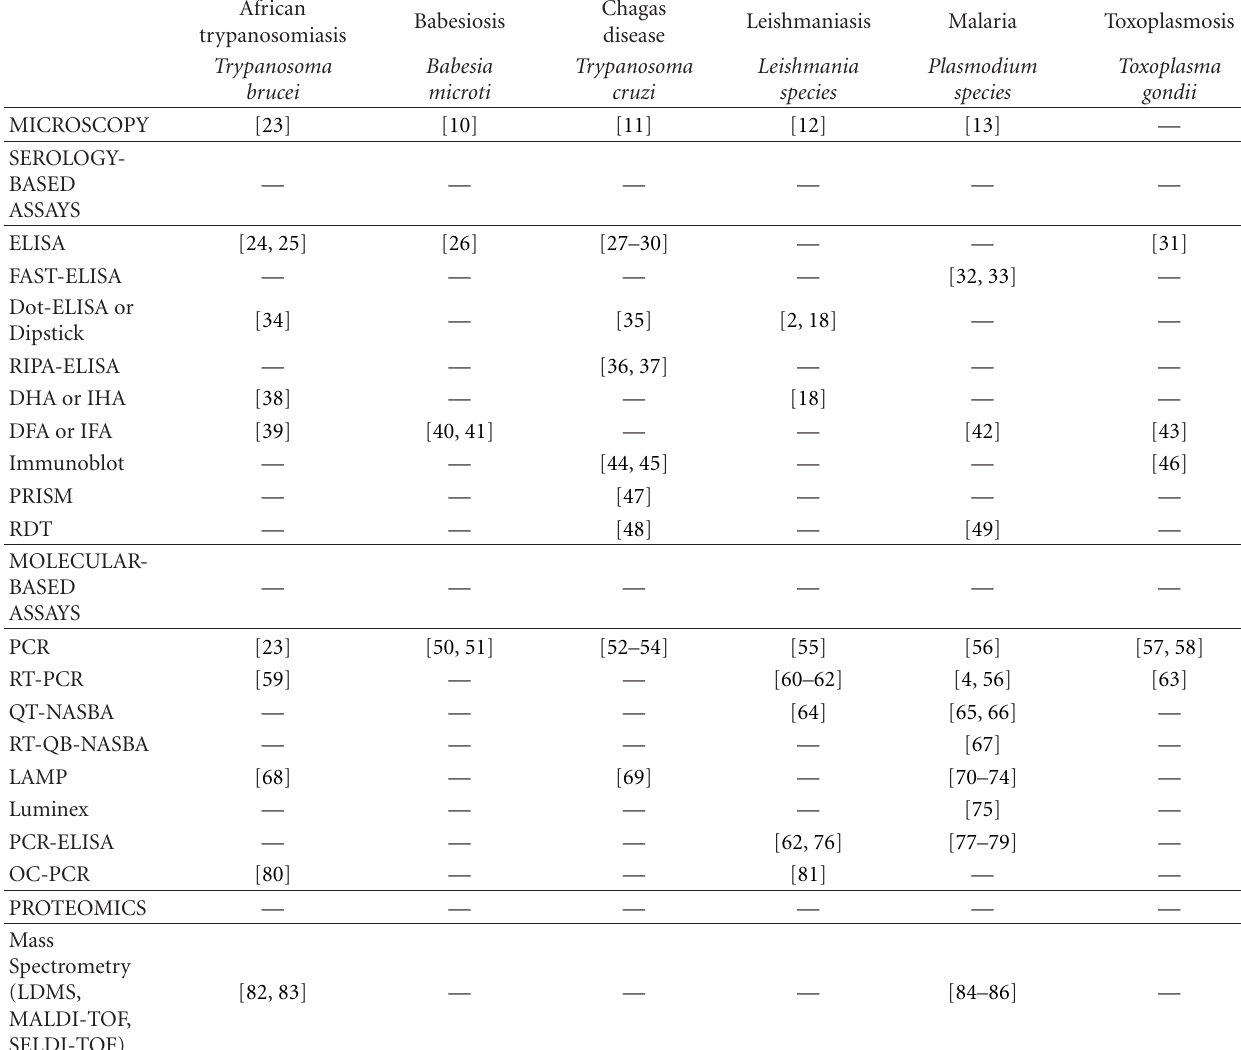
Table 1: Diagnostic tools for the detection of specific blood-borne parasitic